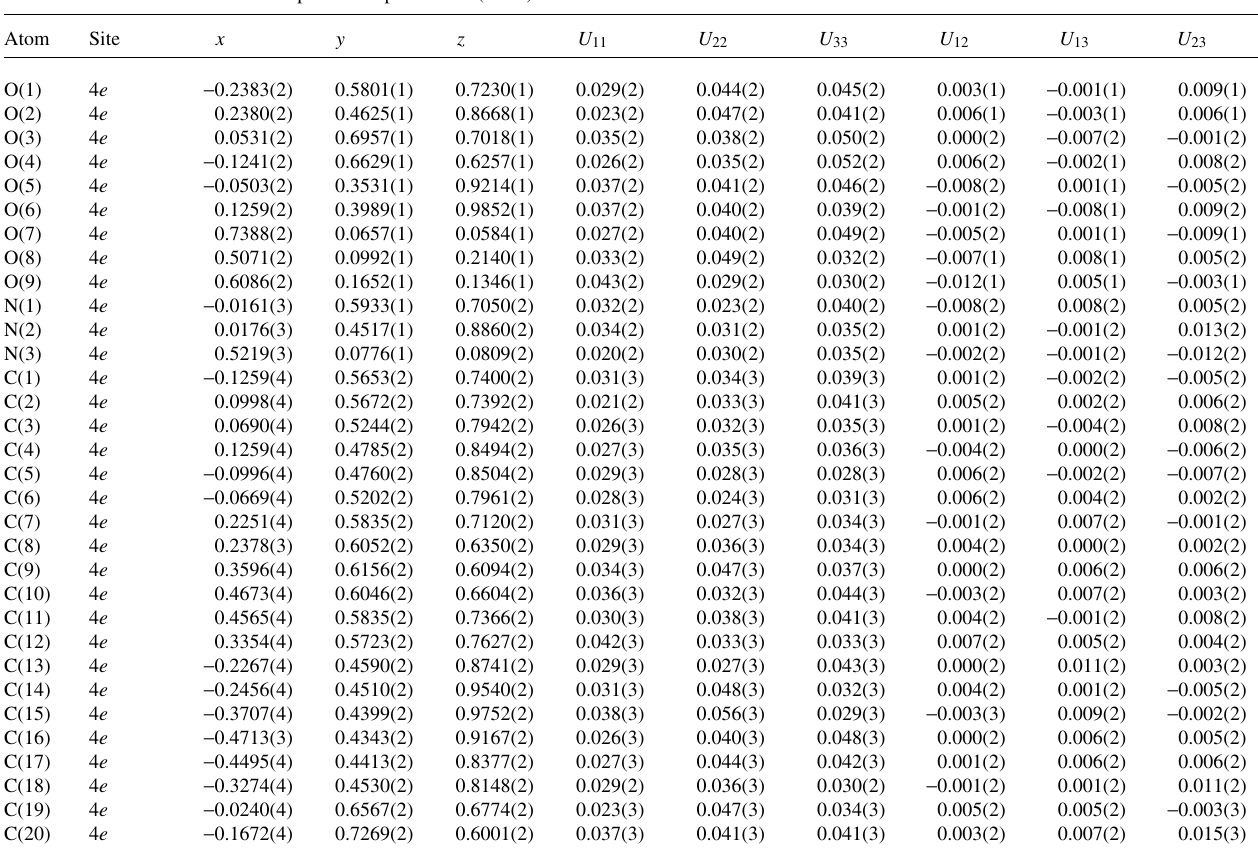
Table 3. Atomic coordinates and displacement parameters (in Å 2 ) .